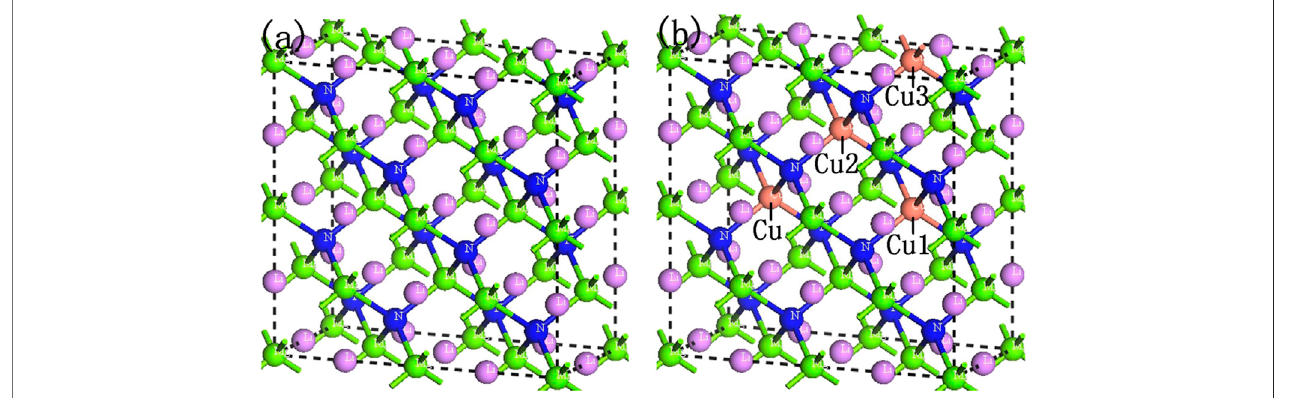
FIGURE 1 | Supercell structures of LiMgN with 48 atoms: (A) LiMgN, (B) Li(Mg 0.875 Cu 0.125